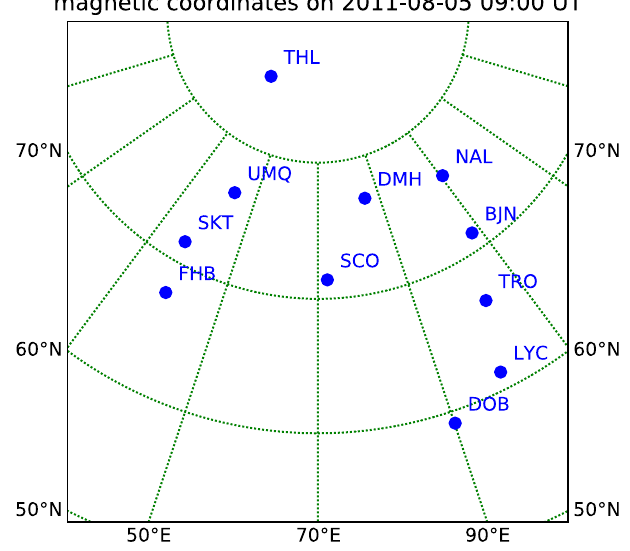
Fig. 1. Ground magnetometer